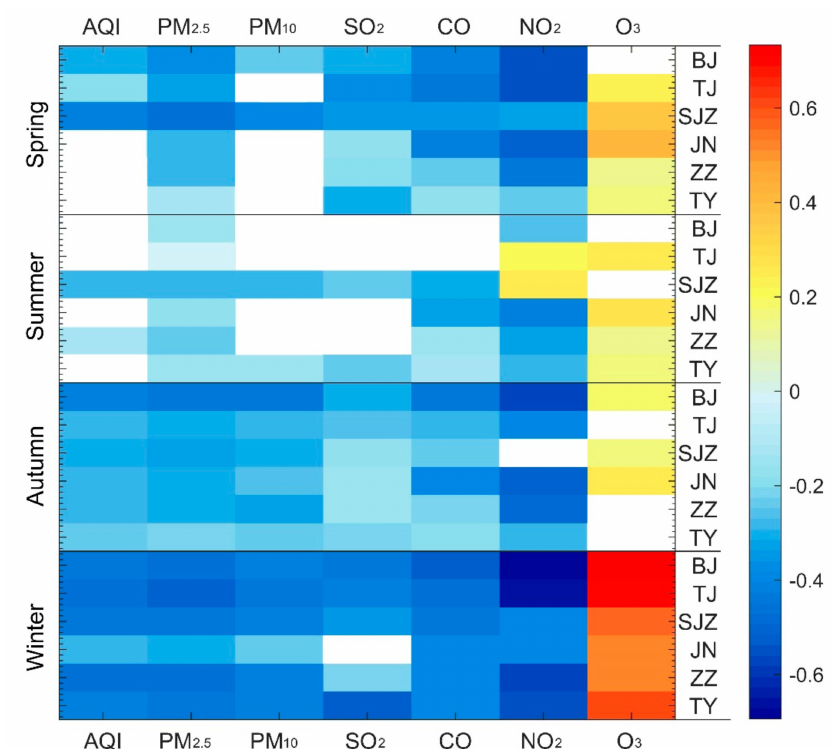
Figure 9. Pearson correlation coe ffi cient of urban wind speed and AQI in di ff erent seasons for capital cities in North China. The white rectangle indicates failed passed the significance test. BJ, TJ, SJZ, JN, ZZ, TY are the abbreviation of Beijing, Tianjin, Shijiazhuang, Jinan, Zhengzhou and Taiyuan,